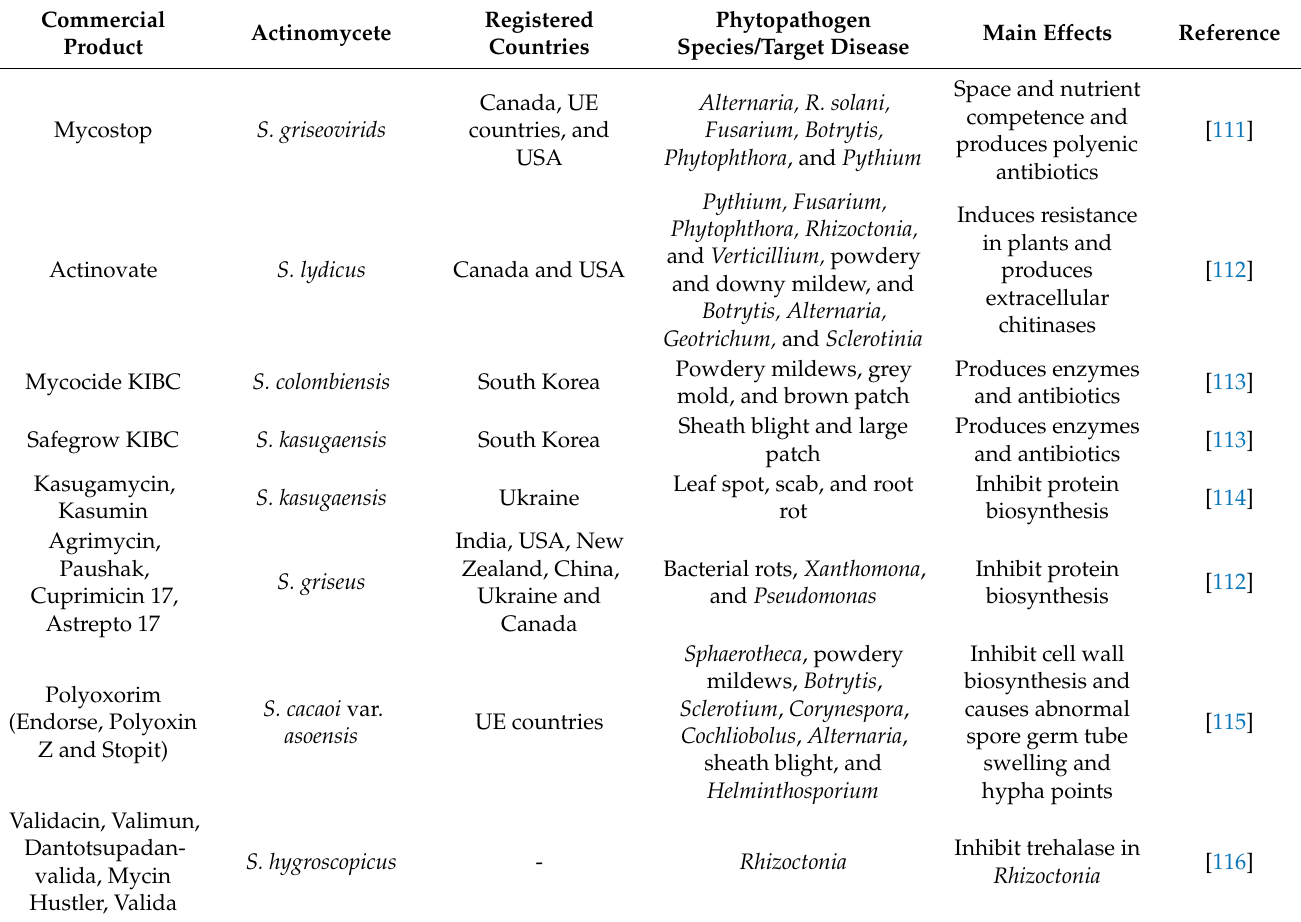
Table 2. Commercial products based in